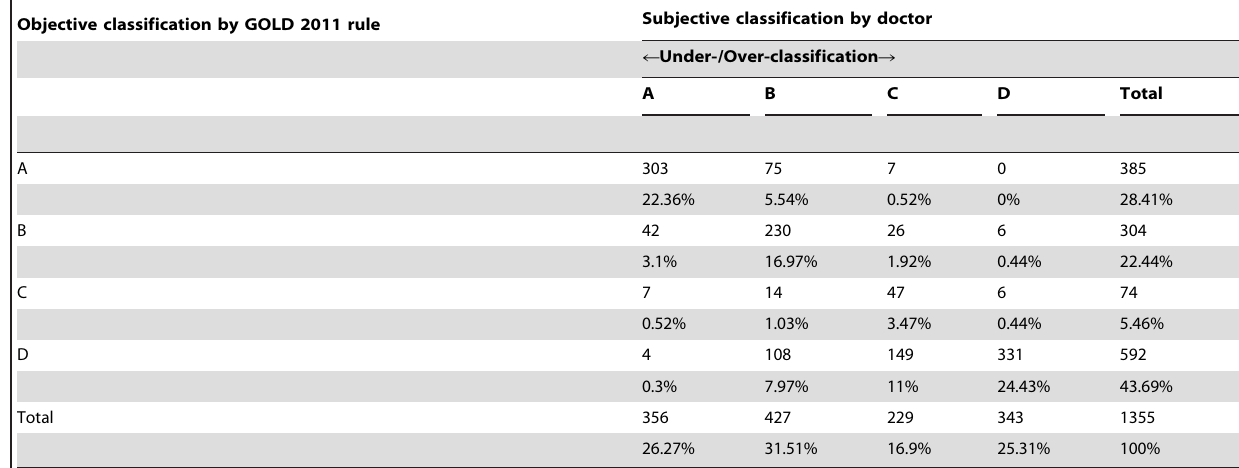
Table 1. Comparison between subjective classification as reported by COPD specialists and objective software-computed classifi- cations based on GOLD 2011 rules for individual